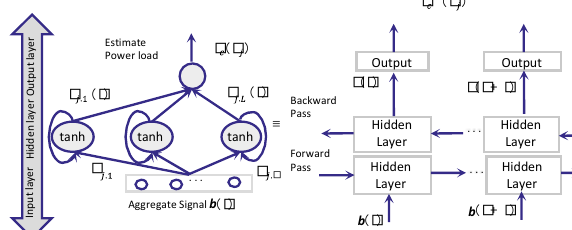
Figure 5. The architecture of a recurrent neural network model with bi-directional capabities (Kaselimi et al., 2019b)